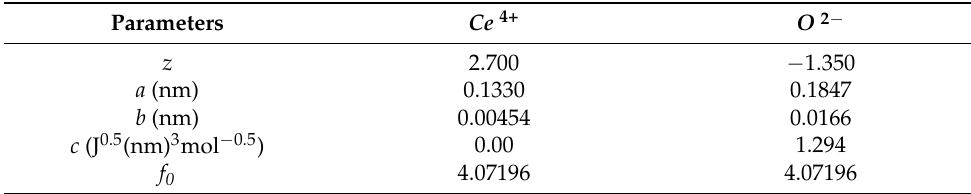
Table 1. Potential parameters for CeO 2 [28].